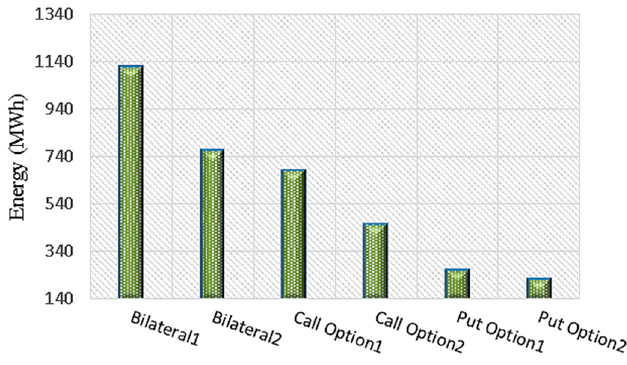
Figure 5. Energy provided through different forward contracts in the third scheme.